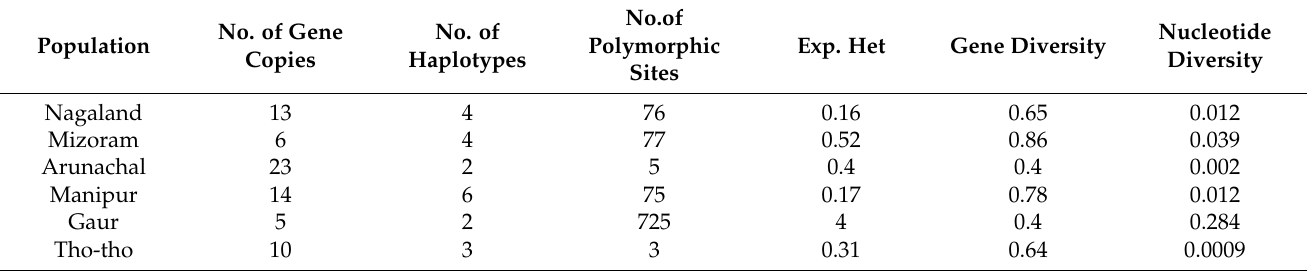
Table 7. Variability in the mtDNA.